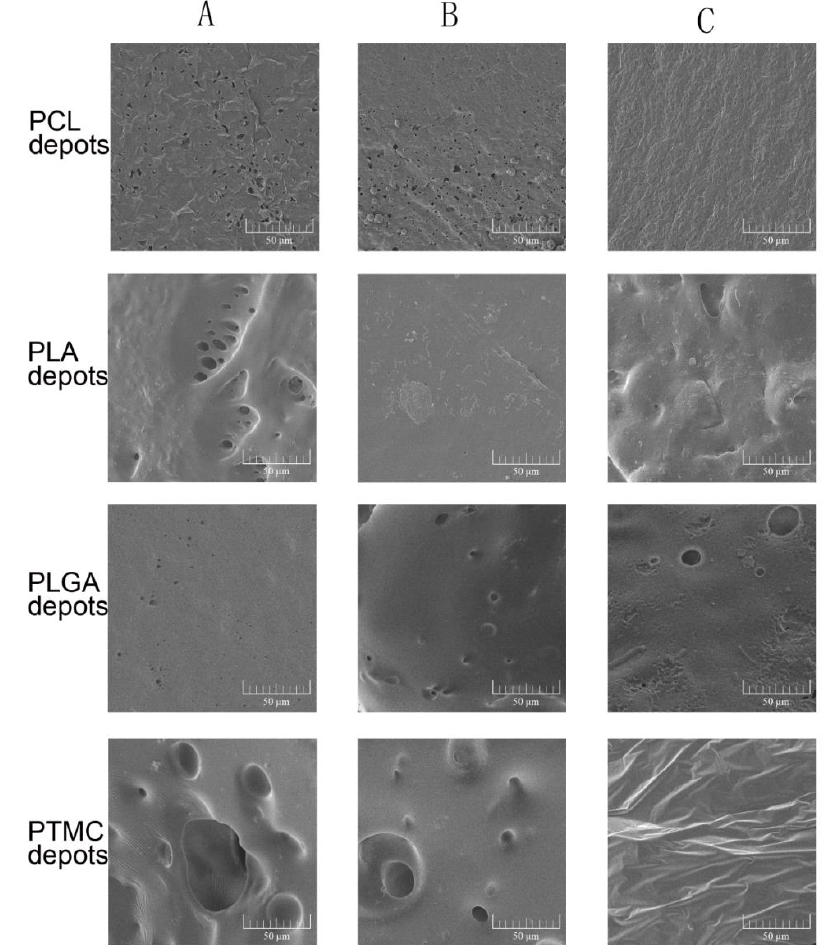
Figure 5. The surface morphologies of different ISFI depots examined by scanning electron microscopy. ( A ) ISFI depots prepared by 15% DMSO; ( B ) ISFI depots prepared by 15% NMP; ( C ) ISFI depots prepared by 15% TA.